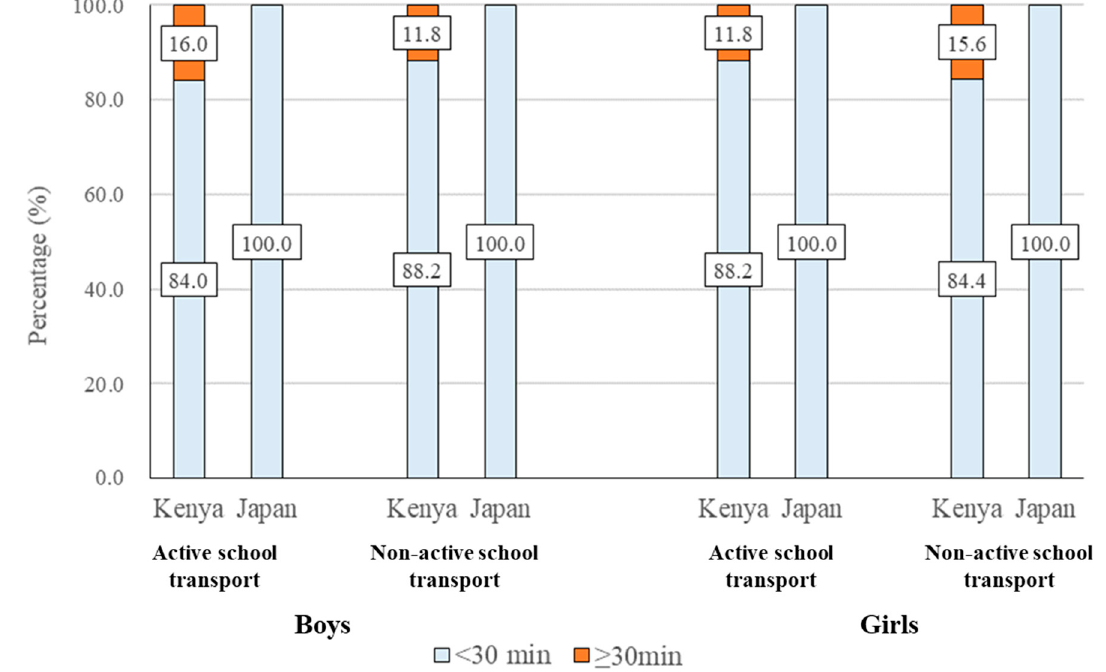
Figure 6. Duration of school transport among Kenyan and Japanese children. The Mann–Whitney